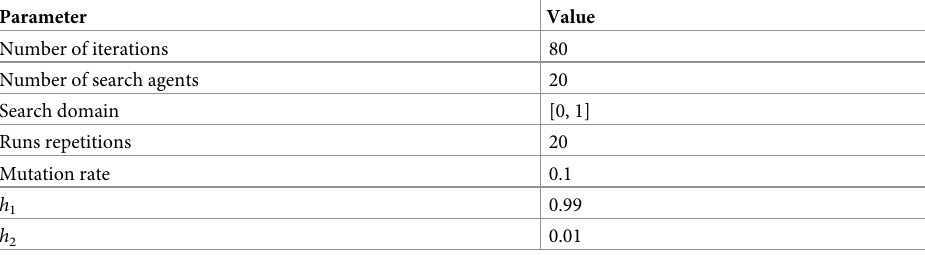
Table 4. Proposed algorithm configuration parameters.